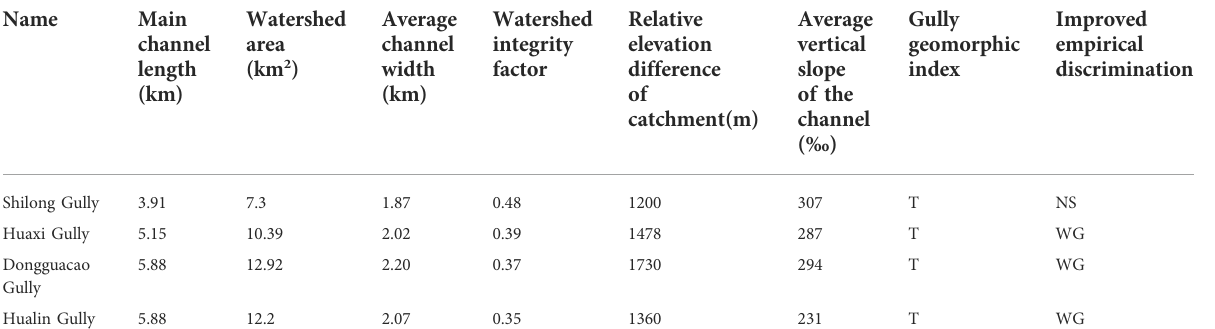
TABLE 4 The inconsistent gullies with the two